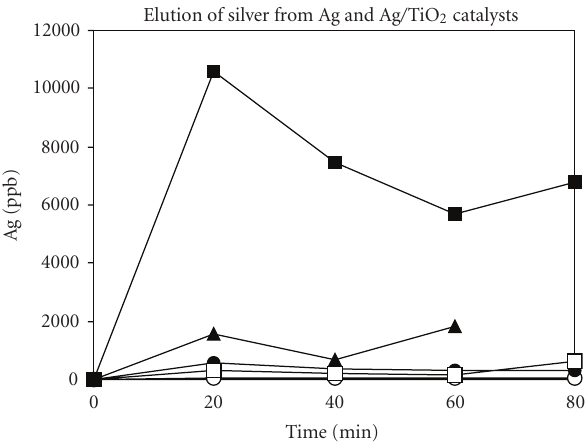
Figure 6: (cid:2) titania under, (cid:3) titania over, (cid:4) silver only, ◦ titania over with